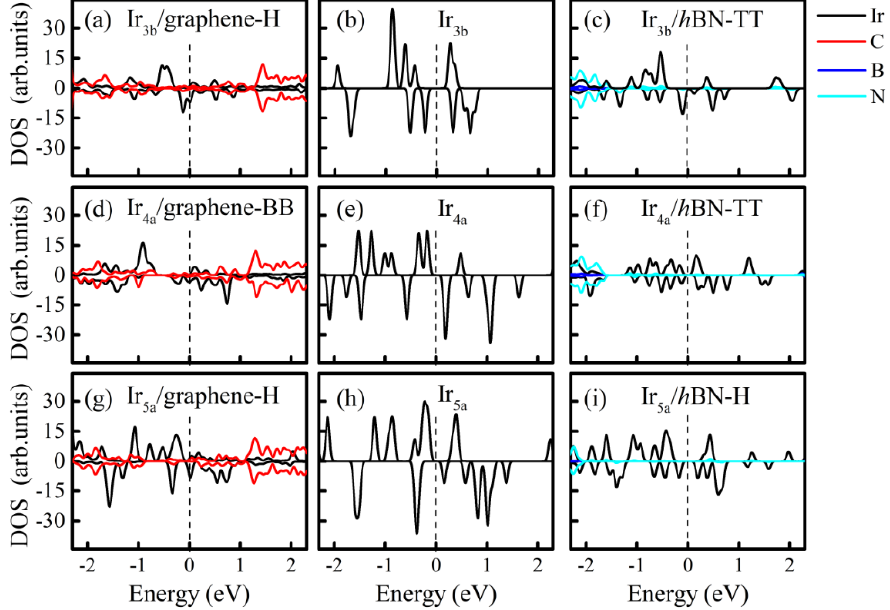
Nanomaterials 2022 , 12 , x FOR PEER REVIEW Figure 5. DOS for free standing Ir n clusters ( b , e , h ) and Ir n /graphene ( a , d , g ) and Ir n / h BN ( c , f , i ) hybrid systems. Contributions of Ir, C, B and N atoms are highlighted in black, red, blue and cyan, respectively.